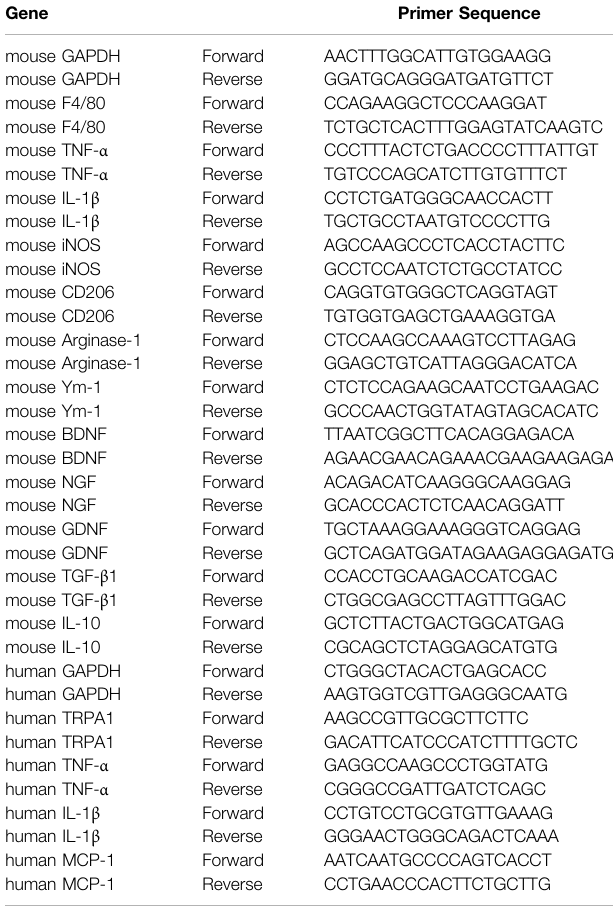
TABLE 1 | Primer sequences used in the